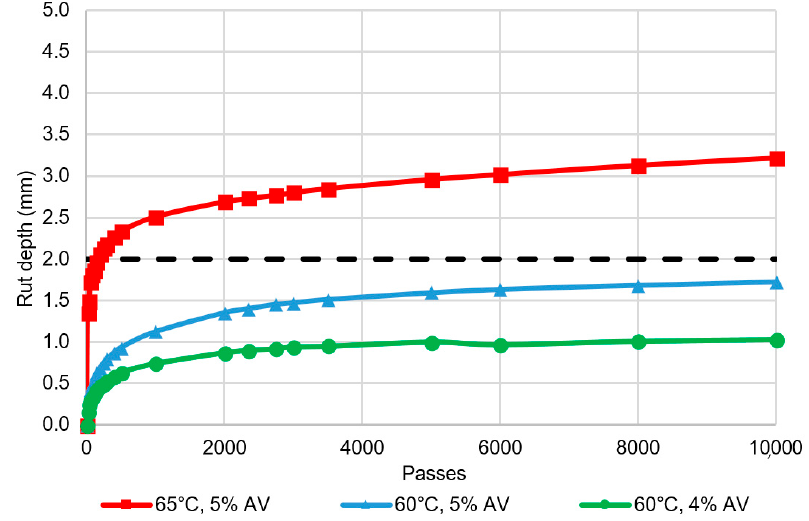
Figure 9. Effect of temperature and air voids on wheel track depth.